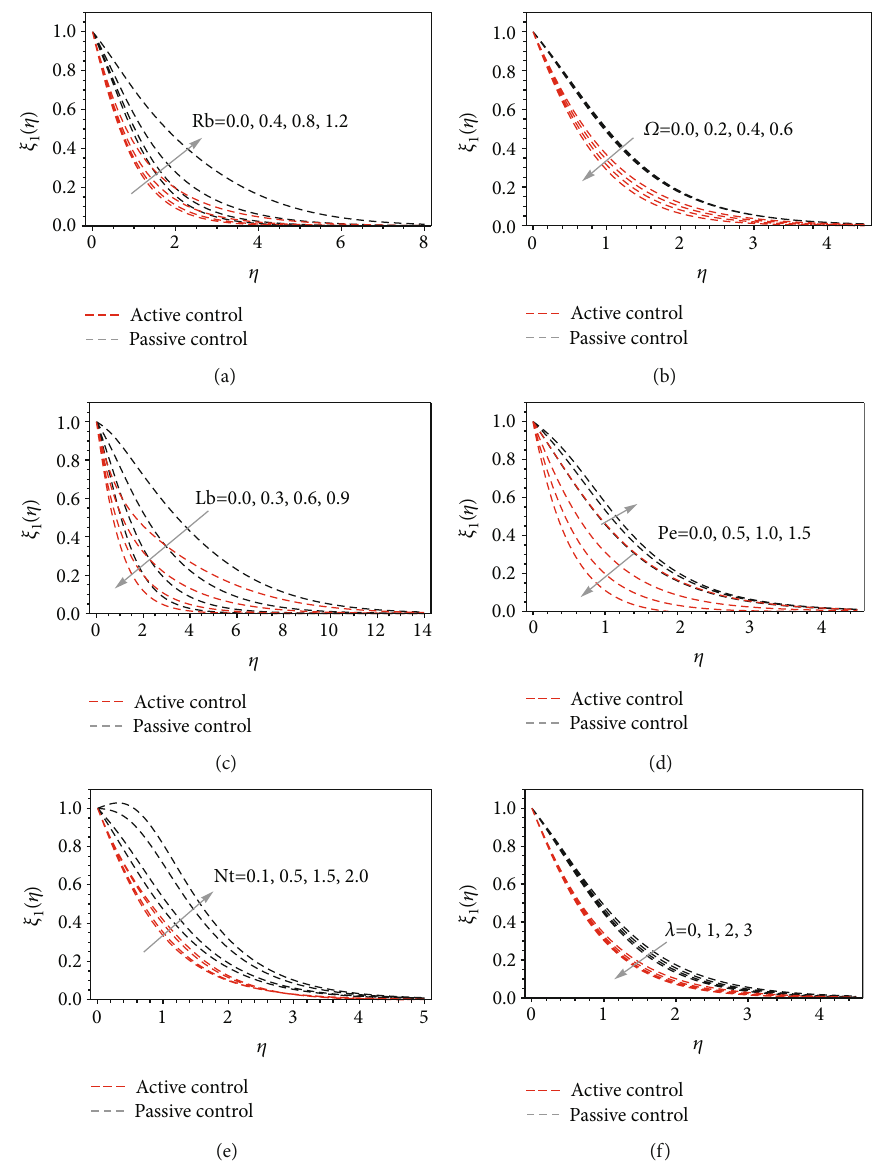
Figure 6: Motile density pro fi le for various values of Rb, Ω , Lb, Pe, Nt , and λ